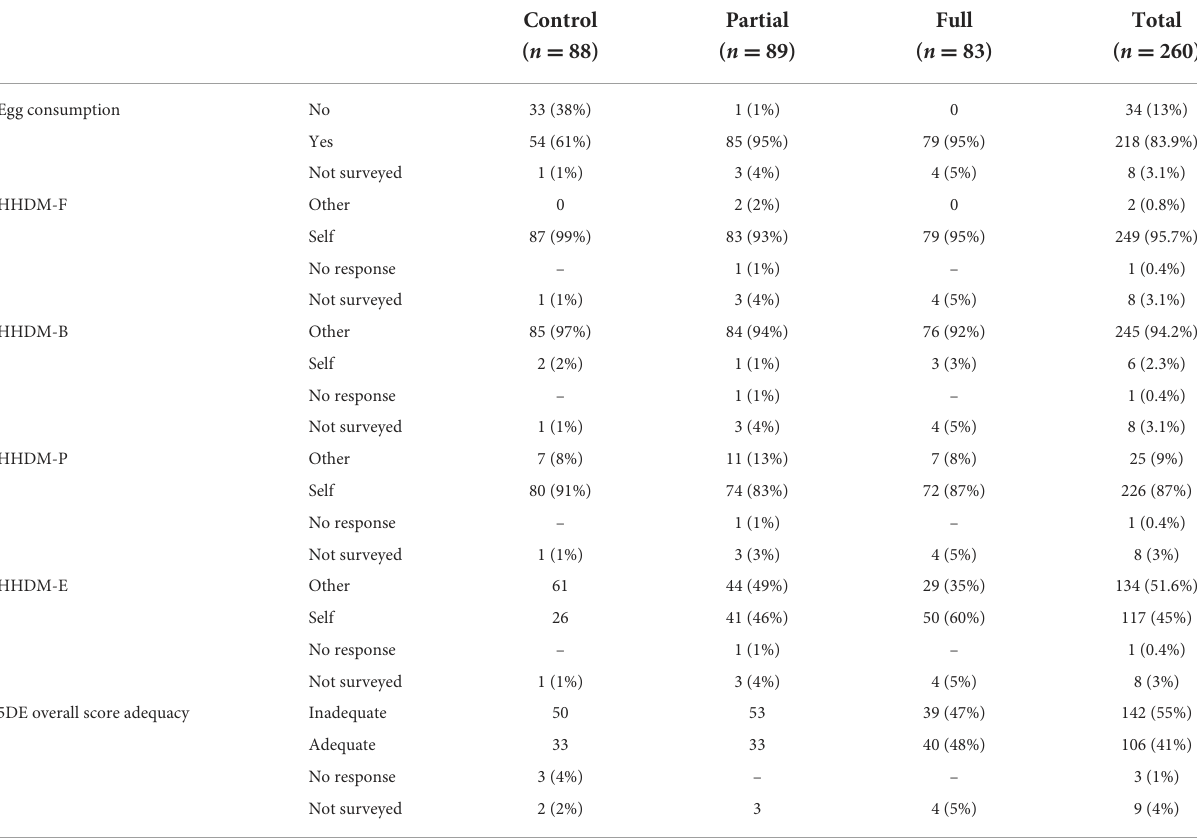
TABLE 2 Endline summary statistics for the study